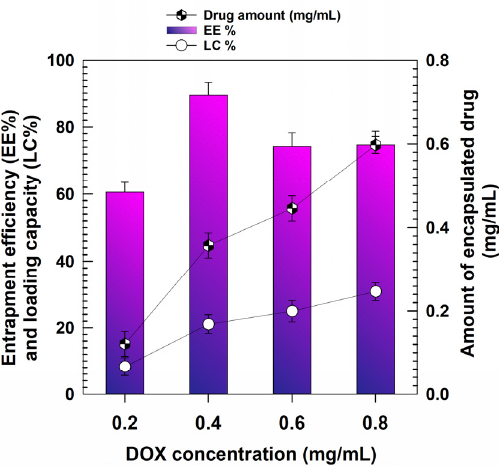
Figure 3. Entrapment efficiency and loading capacity of DOX as a function of the amount of drug initially used.